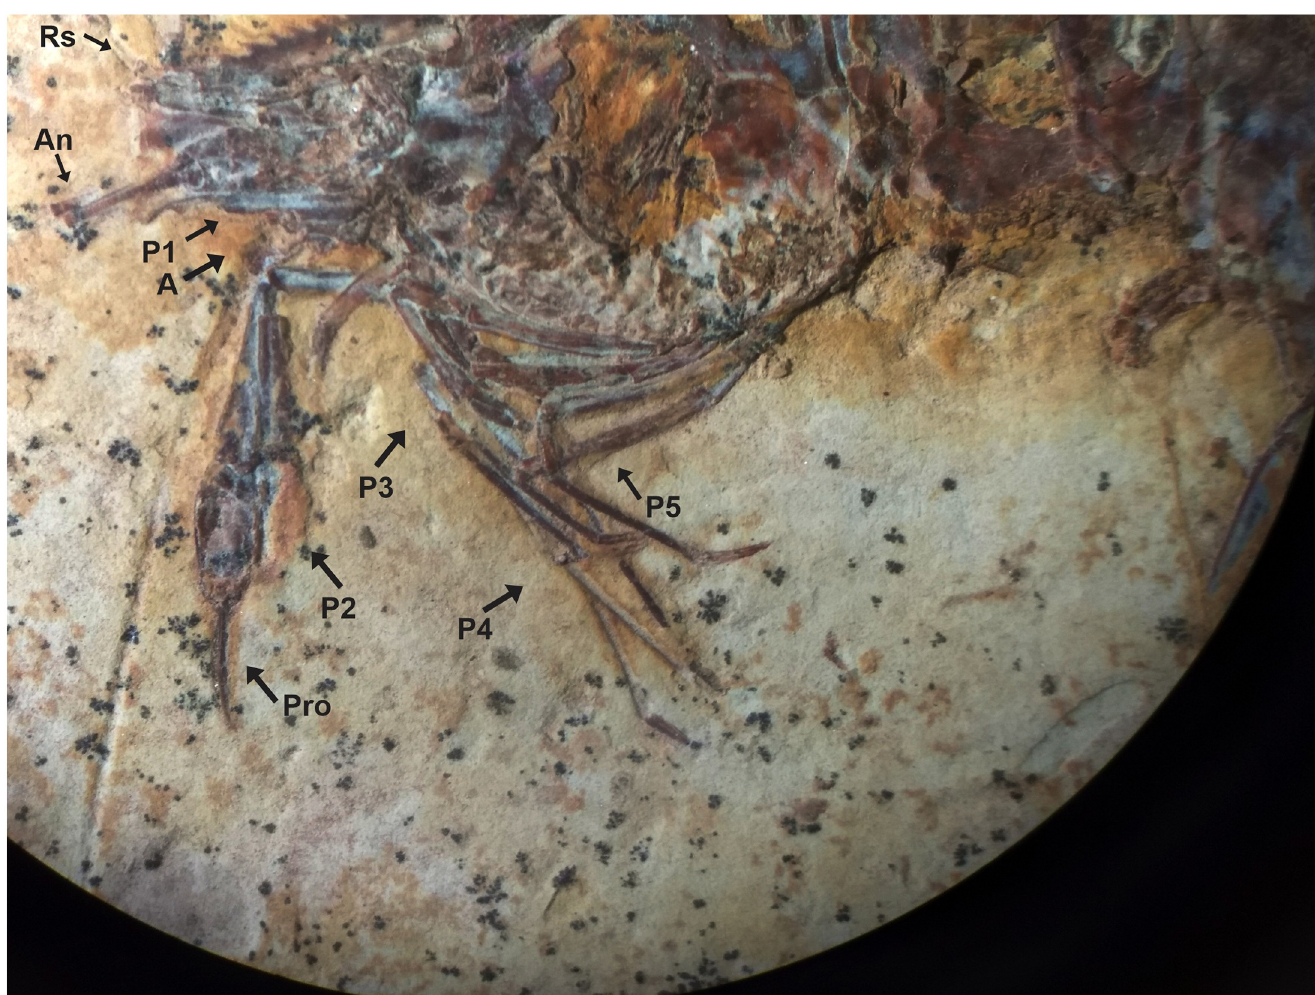
Fig 15. Lateral view of the UFRJ 243/CR. Rs: Rostrum; A: Antenna; An: Antennule; S: Scaphocerite; P1-P5: Pereiopods; Pro: Propodus. Photo by Olga A. Barros.